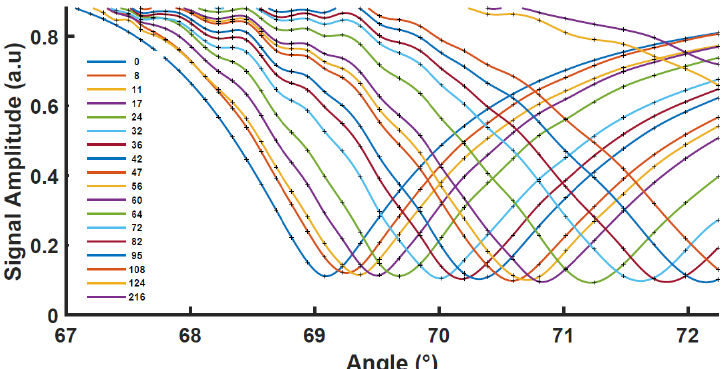
Figure 3. SPR curves for bare Cu thin films deposited on glass (46 nm) being in contact with deionized water. The time indicated in the legend is in minutes. The minimum amplitude is about 0.13 corresponding to a reflectivity of less than 2%.